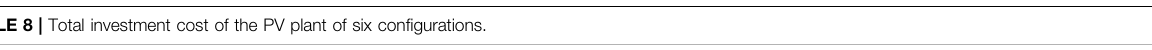
TABLE 8 | Total investment cost of the PV plant of six con fi gurations.